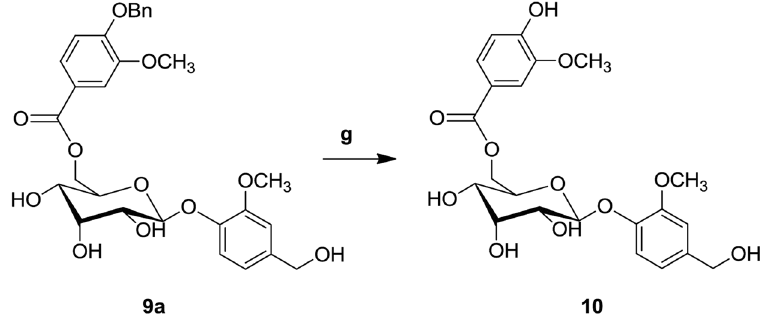
Figure 2. Synthesis of saccharumoside-B. Reagents and conditions: ( g ) Pd/CaCO 3 , H 2 gas,